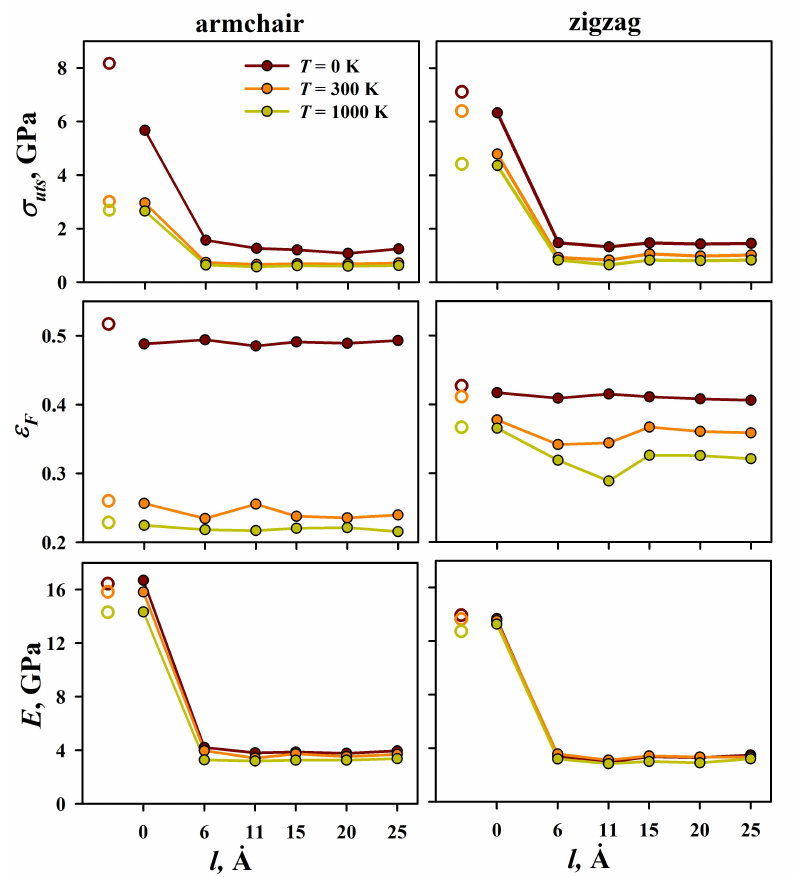
Figure 3. Variations of the ultimate strength σ UTS , fracture strain ε F and elastic modulus for defective graphene under tensile tests along the armchair/zigzag direction as the function of the dipole arm l . Open circles show these values for defect-free